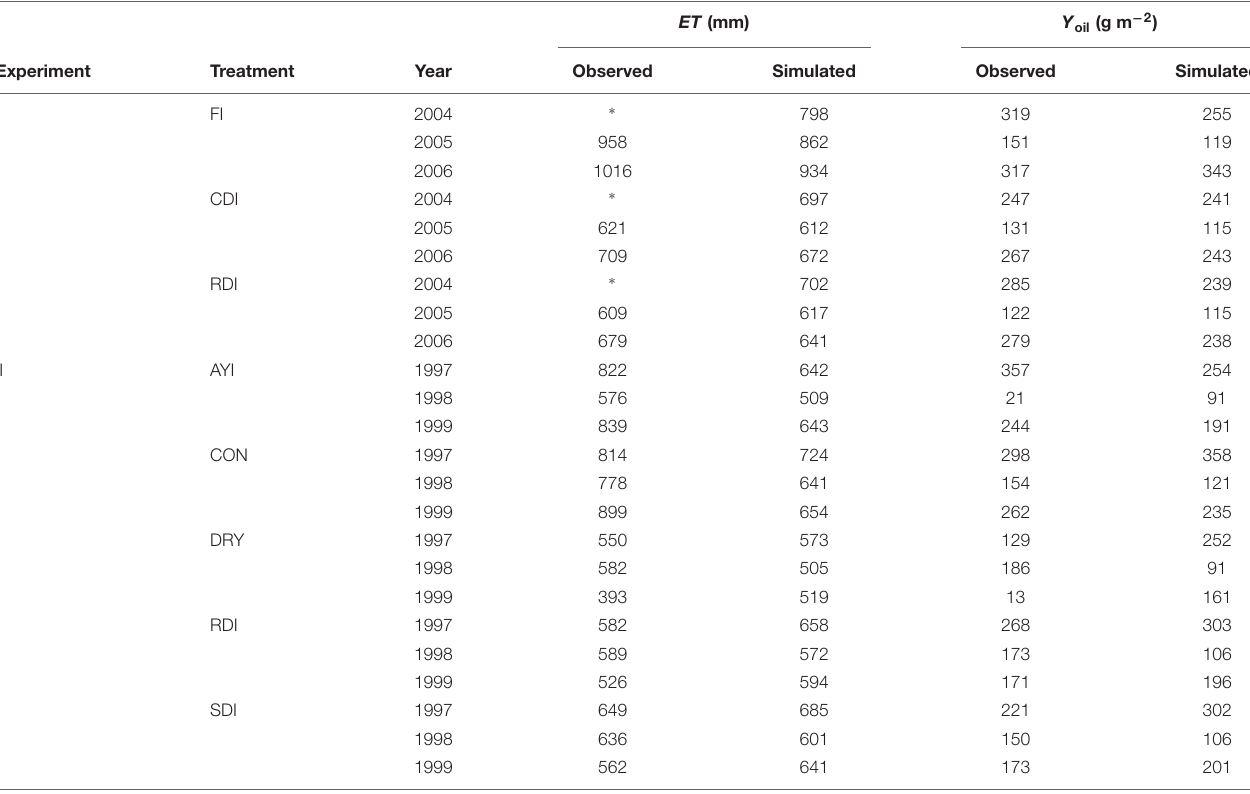
TABLE 1 | Observed (Obs.) and simulated (Sim.) values of seasonal evapotranspiration ( ET ) and oil yield ( Y oil ) in the model tests using the experimental data from Iniesta et al. (2009) (Experiment I) and Moriana et al. (2003) (Experiment